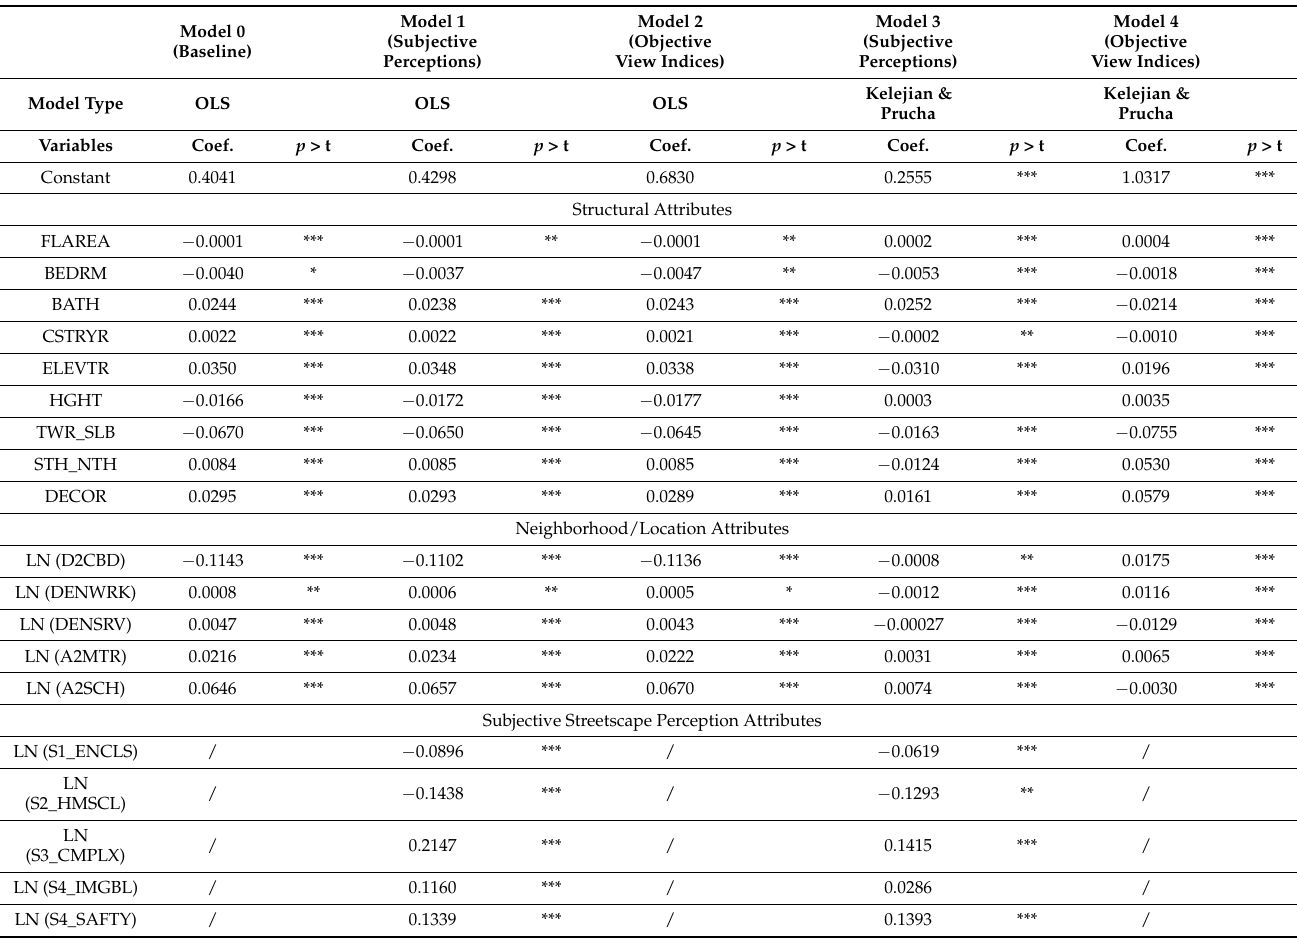
Table A2. OLS and Kelejian and Prucha model regression